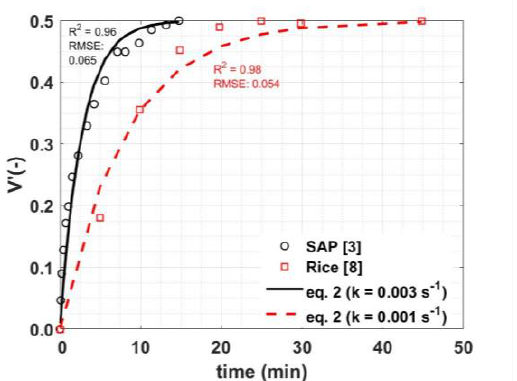
Fig. 2 Time evolution of the dimensionless swelling parameter ( 𝑉 ′ ) and fitting with Eq. (2) for a single grain of rice [8] and SAP [3].